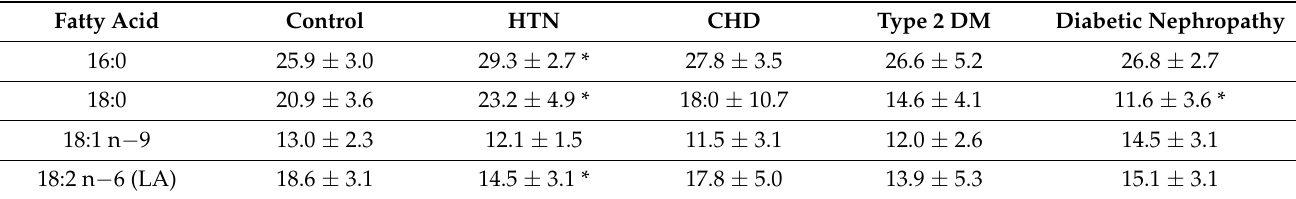
Table 5. The percentage of distribution of fatty acids from plasma phospholipid fraction in patients with hypertension (HTN), coronary heart disease (CHD), type 2 diabetes mellitus, and diabetic nephropathy that are common with advanced age. Fatty